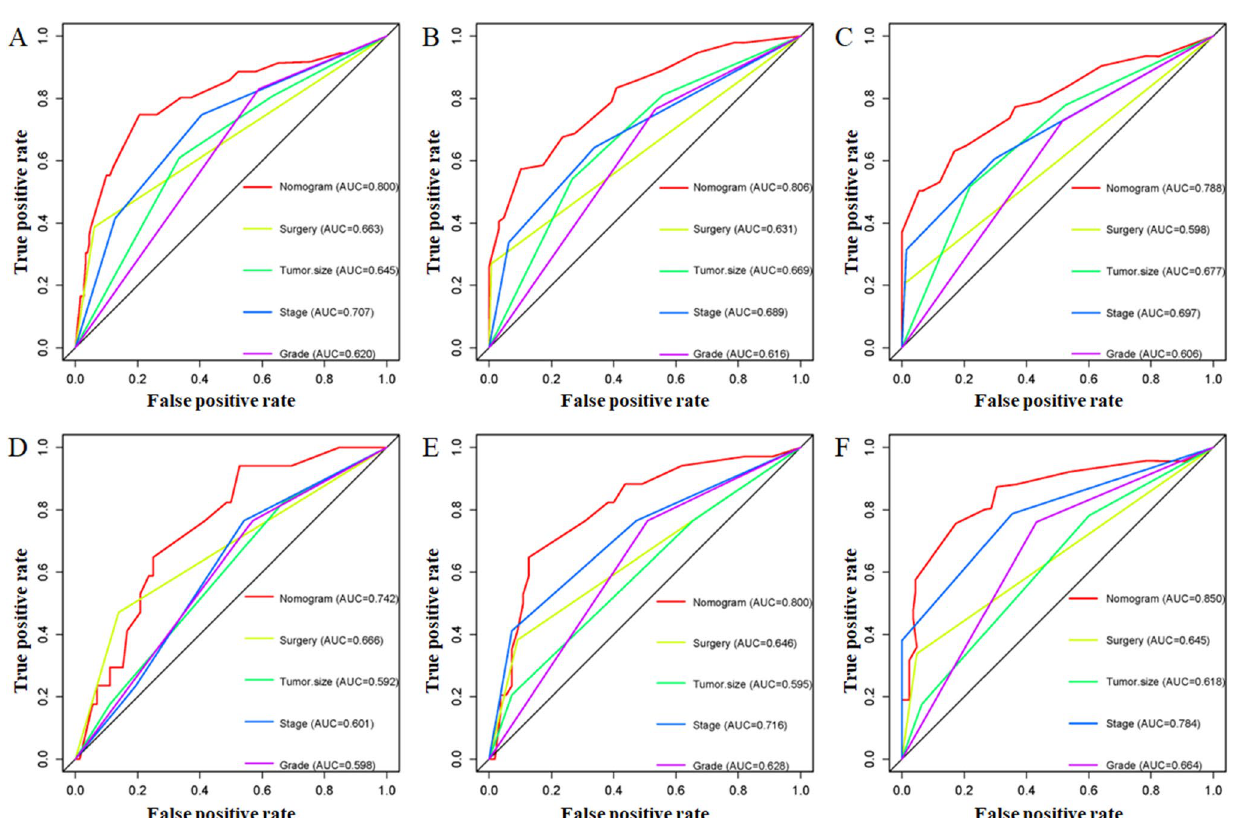
Figure 5. The comparison of the prediction accuracy between the nomogram and independent prognostic predictors. The ROC curves of nomogram and all independent prognostic predictors at 1 ( A ), 3 ( B ), and 5 ( C ) years in the training set and at 1 ( D ), 3 ( E ), and 5 ( F ) years in the validation set. Figure was generated by R software version 4.03 (http:// www.r- proje ct.